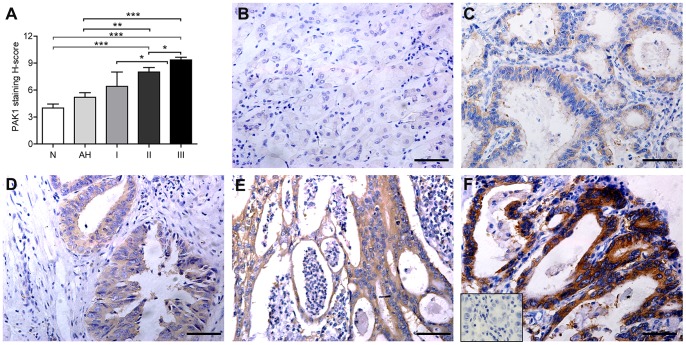
H-score and representative immunohistochemical stainings.(A) The H-score of surrounding normal GEJ epithelium (N, n = 9), atypical hyperplasia (AH, n = 14) and stage I–III GEJ tumor (n = 6, 31, and 76, respectively); error bars represent “mean + SEM”; ***P<0.001, **P<0.01, *P<0.05. (B) Surrounding normal GEJ epithelium is not or weakly stained. (C) An atypical hyperplasia exhibits piling up of diffused and light staining. (D) Light-to-moderate diffused staining in a stage I GEJ tumor. (E) Diffused and moderate staining in a tumor in stage II GEJ tumor. (F) A GEJ tumor in stage III is strongly stained. Insert in (F) showed rabbit IgG as negative control. Scale bar  =  50 µm.